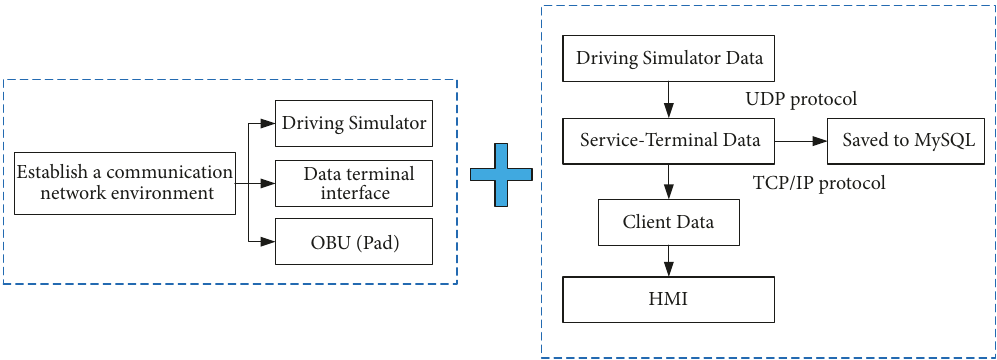
Figure 1: Architecture design diagram of the OBU.